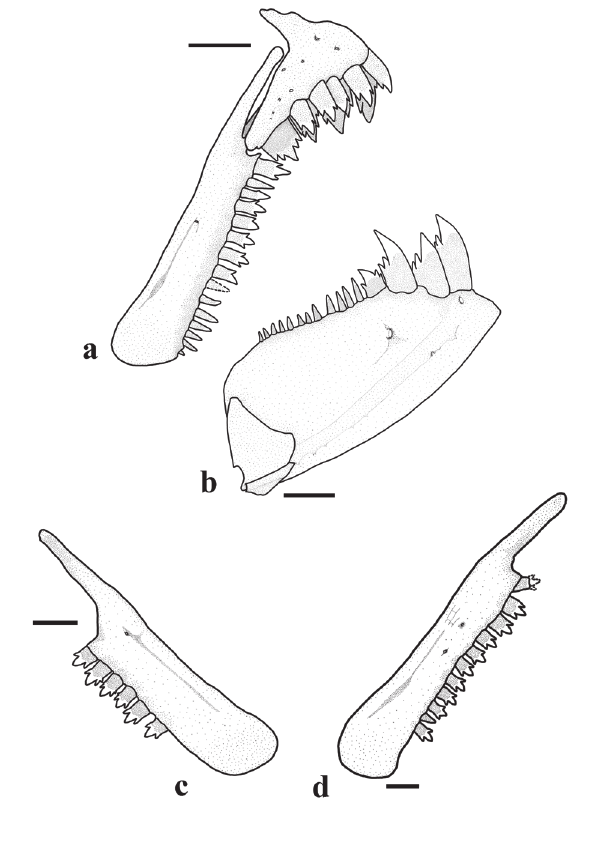
Fig. 3. Chrysobrycon eliasi , AI 287, paratype, female 32.95 mm SL. Lateral view of jaw and dentition: ( a ) Upper jaw, right side. ( b ) Lower jaw, right side. Lateral view of maxilla: ( c ) C. hesperus , maxilla, left side, male, MUSM 28665. ( d ) C. myersi , maxilla, right side, male, MUSM 38671. Scale bar = 1 mm.